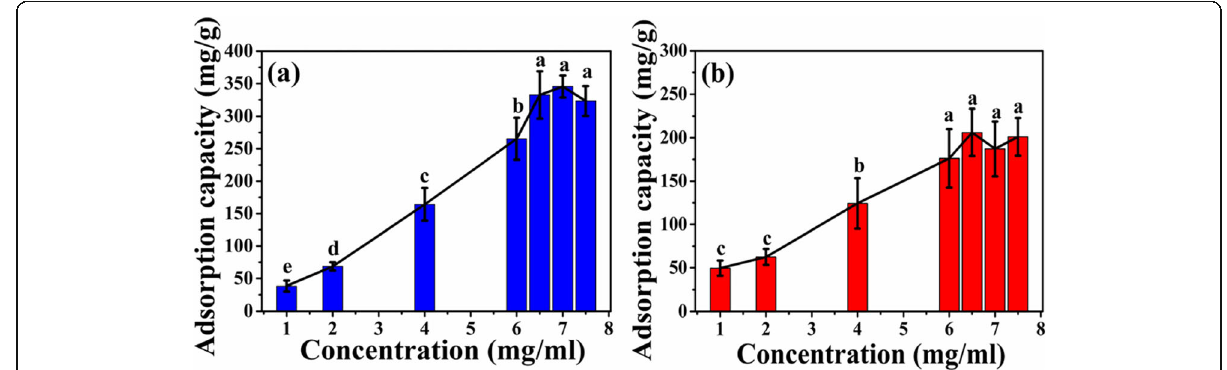
Fig. 7 Adsorption curve of microspheres at different initial concentration of HEL. a ATP-CG microspheres. b ATP-CL